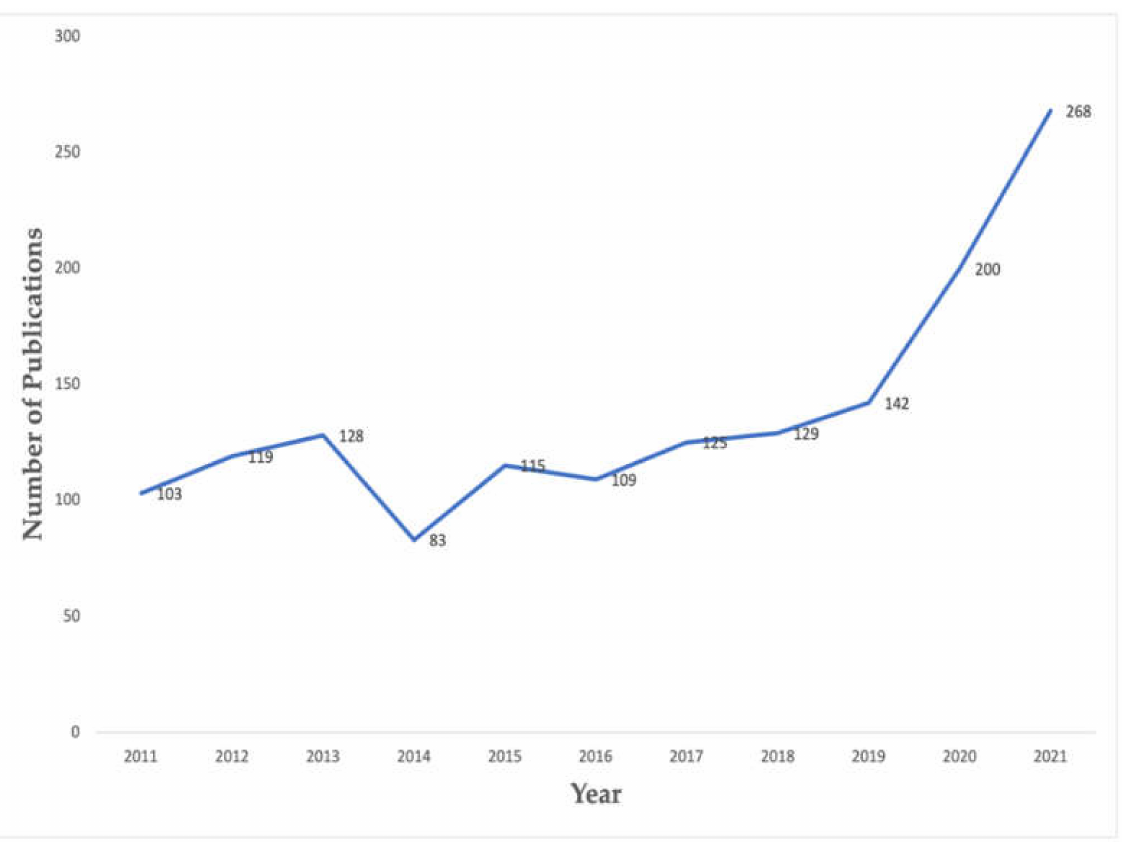
Figure 2. The number of publications on nutrition and cancer from 2011 to